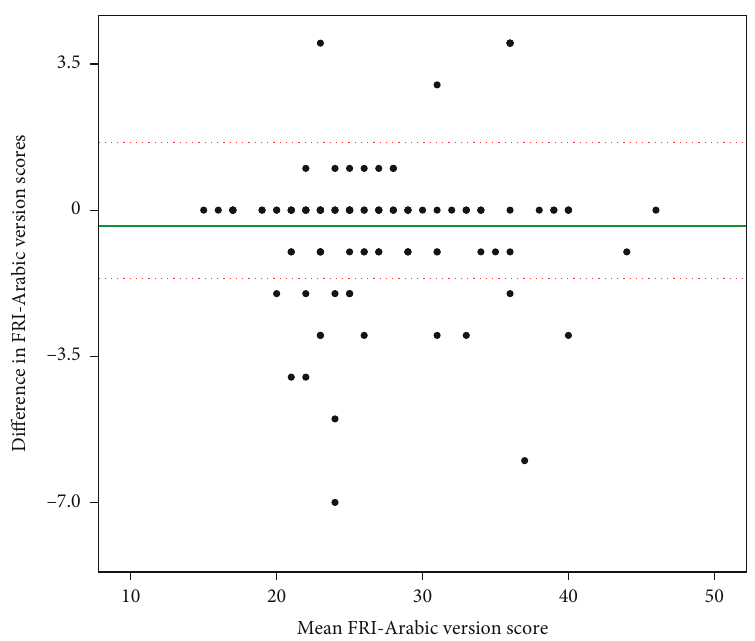
Figure 4: Agreement of the FRI-Ar scores between baseline and 24 hours using the Bland-Altman